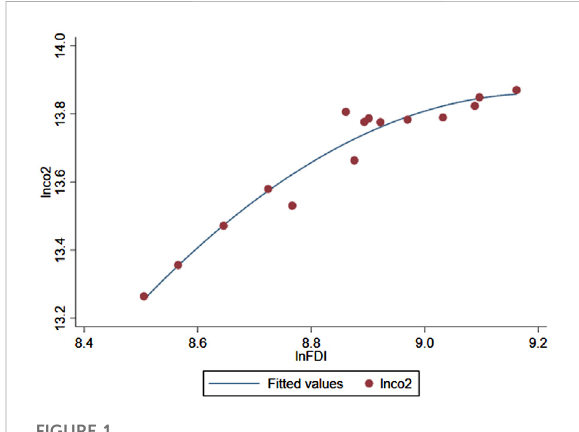
FIGURE 1 The correlation of FDI and China's carbon